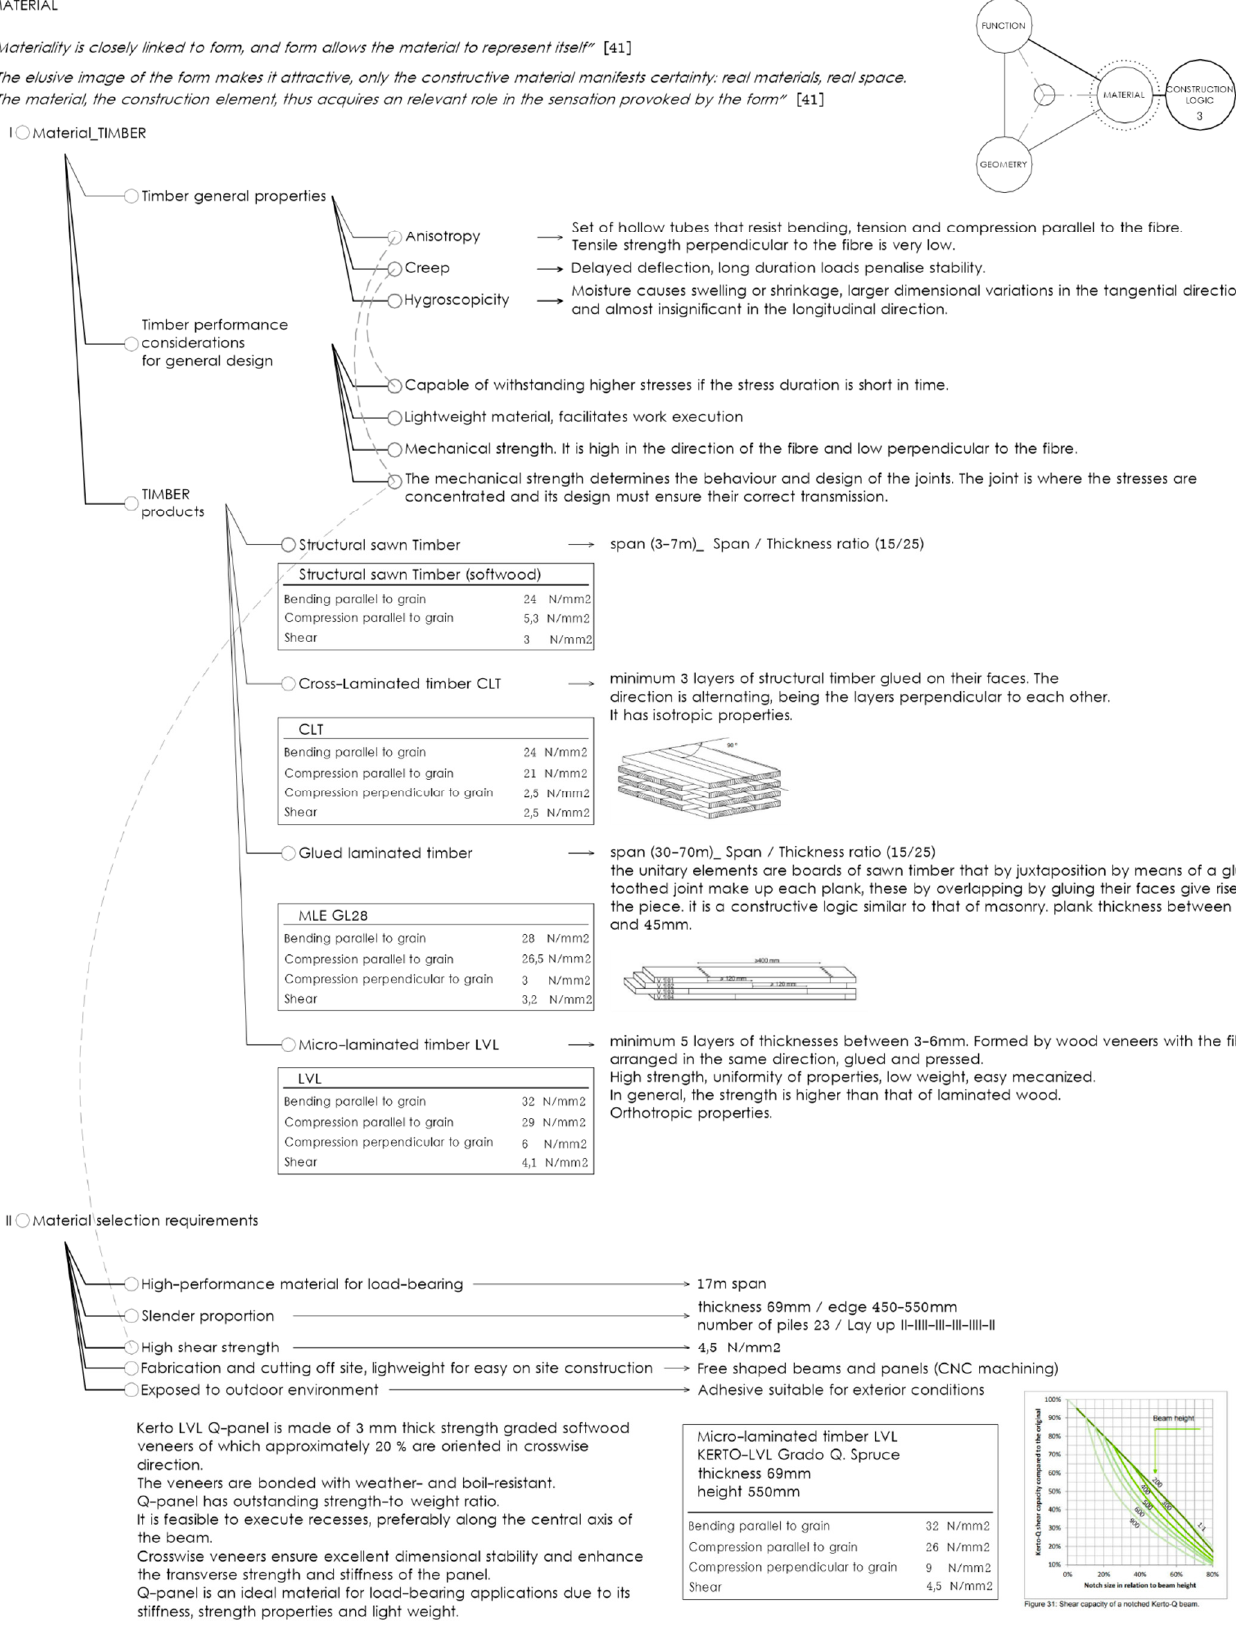
Figure 14. Construction logic matrix 3.